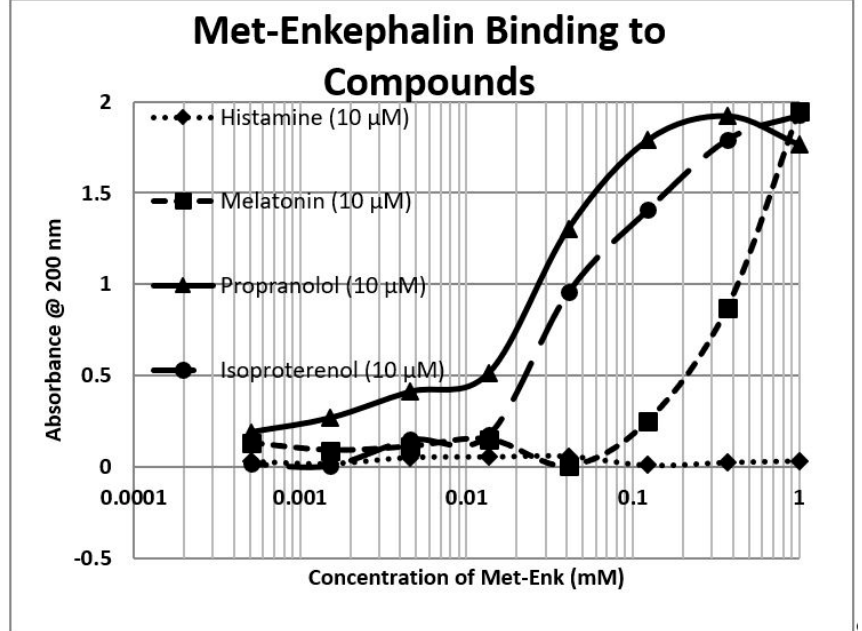
Figure 2. Ultraviolet spectroscopy study of morphine sulfate binding to various drugs and neurotransmitters. Note that epinephrine and propranolol bind to morphine in a two-phase manner, with high affinity binding in the high nanomolar to low micromolar range and lower affinity binding around the 40 μ M to 50 μ M range. See Table 1 and Figures 1 and 3 for additional data.